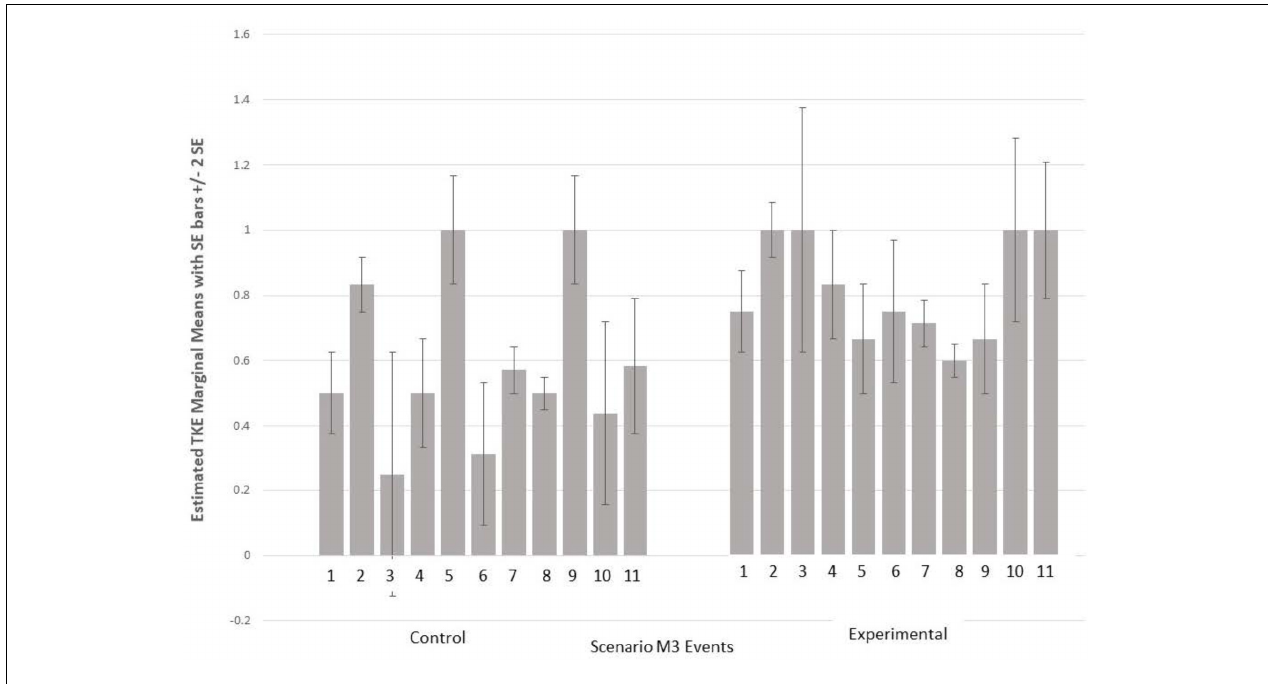
FIGURE 2 | Estimated TKE marginal means and standard error for M3 scenario events.